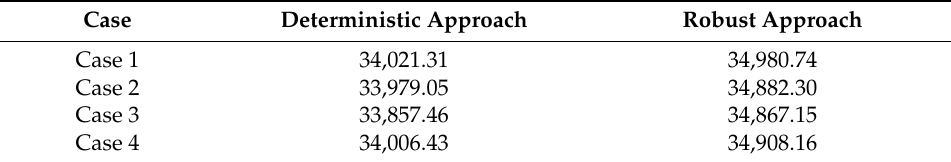
Table 7. Payoff of the REP in the worst-case market price realization ( €